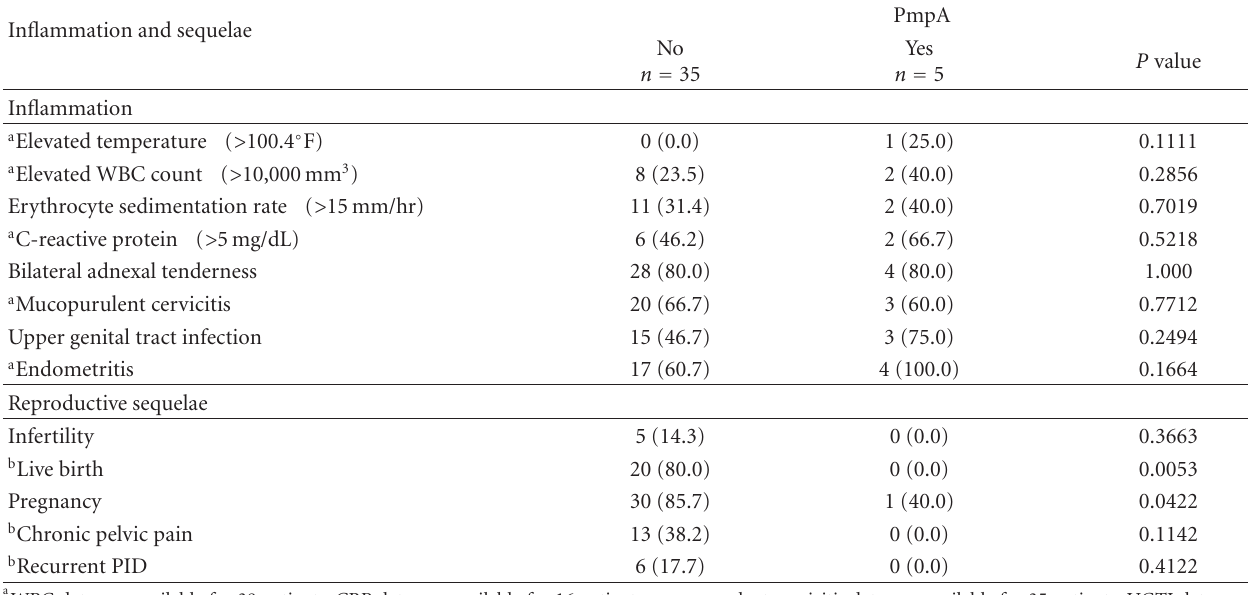
Table 2: Frequency of baseline inflammatory markers and reproductive sequelae by PmpA antibody expression. Inflammation and sequelae